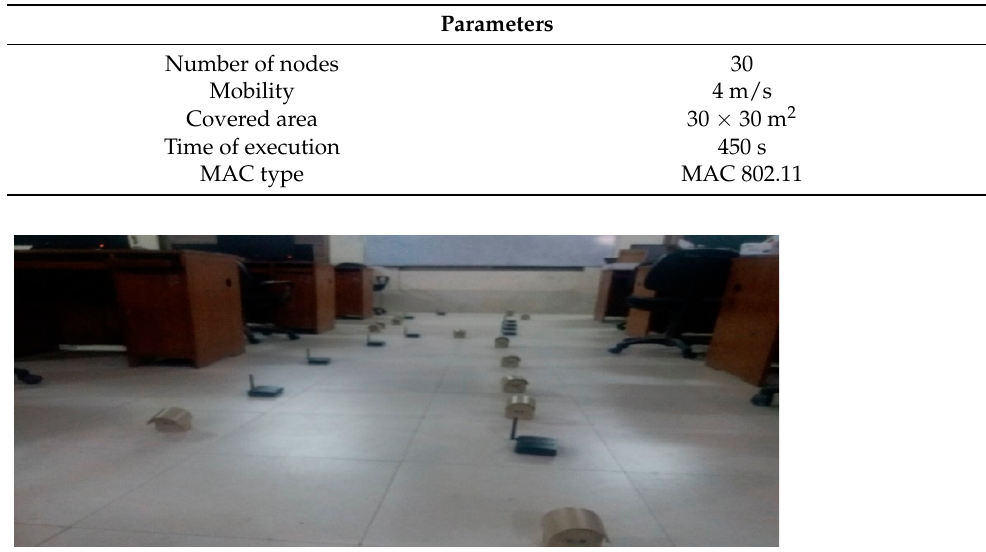
Figure 8. Different Scenarios performed in the Computer Science Lab, Bacha Khan University, Charsadda. Scenario 1: Here, the number of receivers is 40 with 30 × 30 m 2 covered area. Here mobility changes from 0 to 4 m/s with 1 m/s